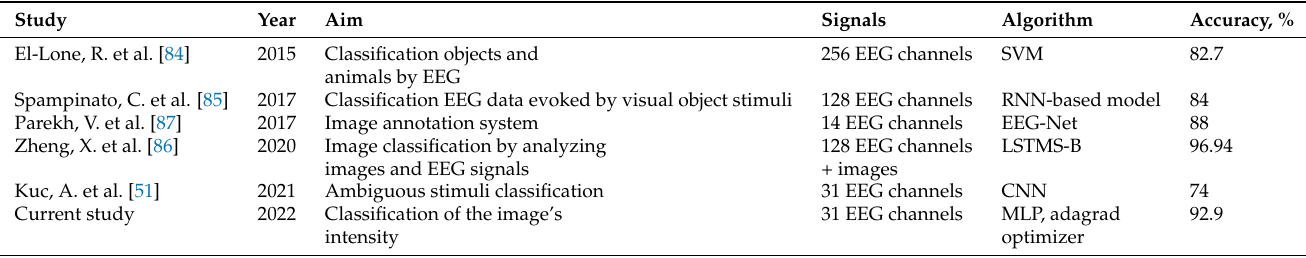
Table 17. Comparison with the existing